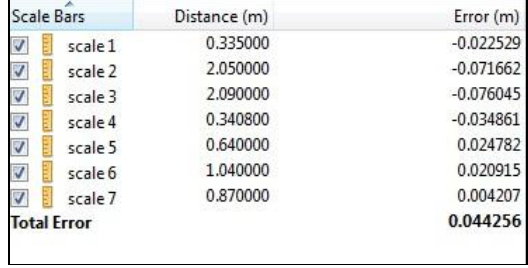
Figure 11. Average deviation in Agisoft